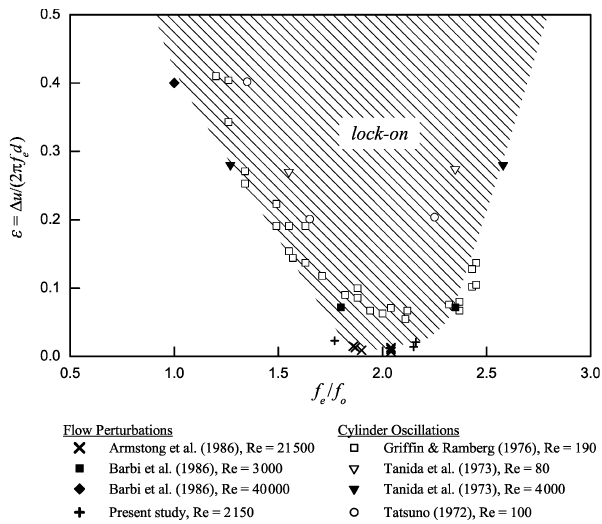
Fig. 10. The limits of the lock-on regime. Figure 9. The subharmonic lock-on region of vortex shedding from a circular cylinder subjected to global symmetrical perturbations in-line with the free stream, i.e., perturbations of the free-stream velocity and streamwise cylinder oscillations. In the vertical axis label, ∆ u is the peak-to-peak amplitude of velocity perturbation, f e is the exciation frequency, and d is the cylinder diameter, while in the horizontal axis, label f o is the natural frequency of vortex shedding in the unperturbed flow. Reprinted from the work by the authors of [19] with permission from